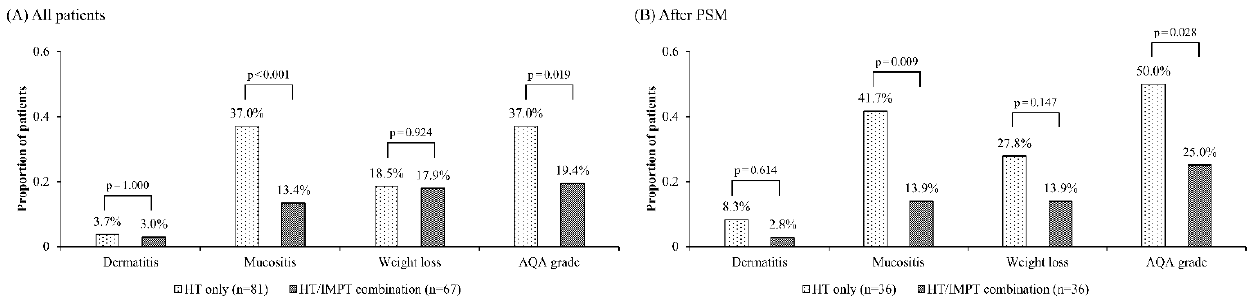
Figure 2. Grade 3 or higher toxicity distribution by treatment group among all patients ( A ), and matched patients ( B ). PSM, Propensity Score Matching; IMRT, Intensity-Modulated Radiation Therapy; IMPT, Intensity-Modulated Proton Therapy.